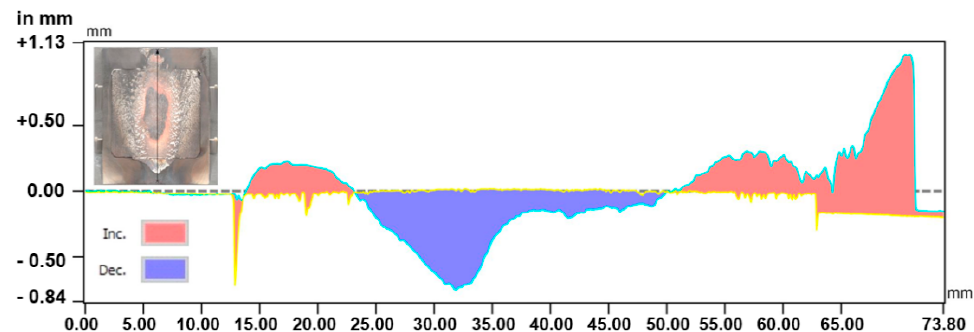
Figure 7. Comparative profile of height along the vertical line of the sample exposed to a plume created with 8% Al propellant.